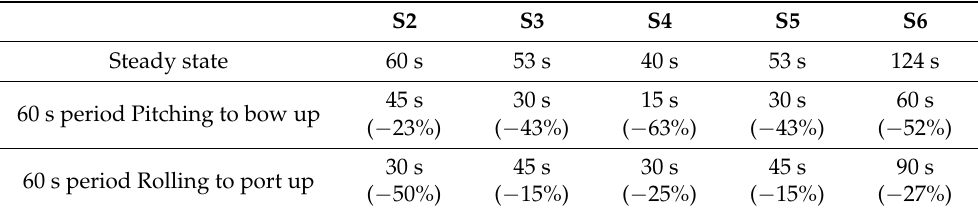
Table 4. Time for hydrogen to reach each sensor according to the ship motion